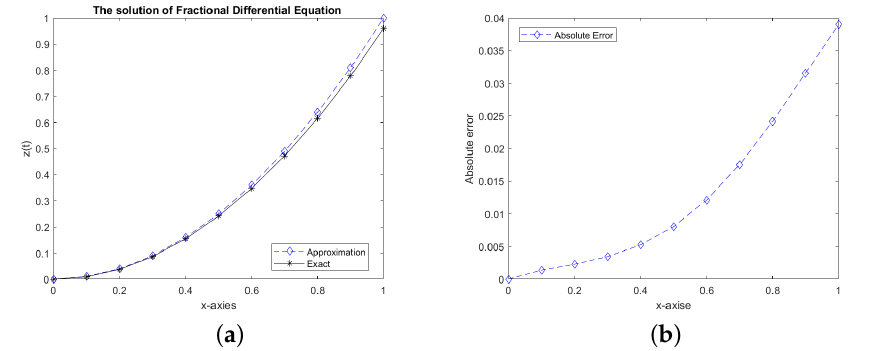
Figure 1. For Example 5: ( a ) compares the numerical and exact solutions of the FDE; ( b ) displays the absolute error between